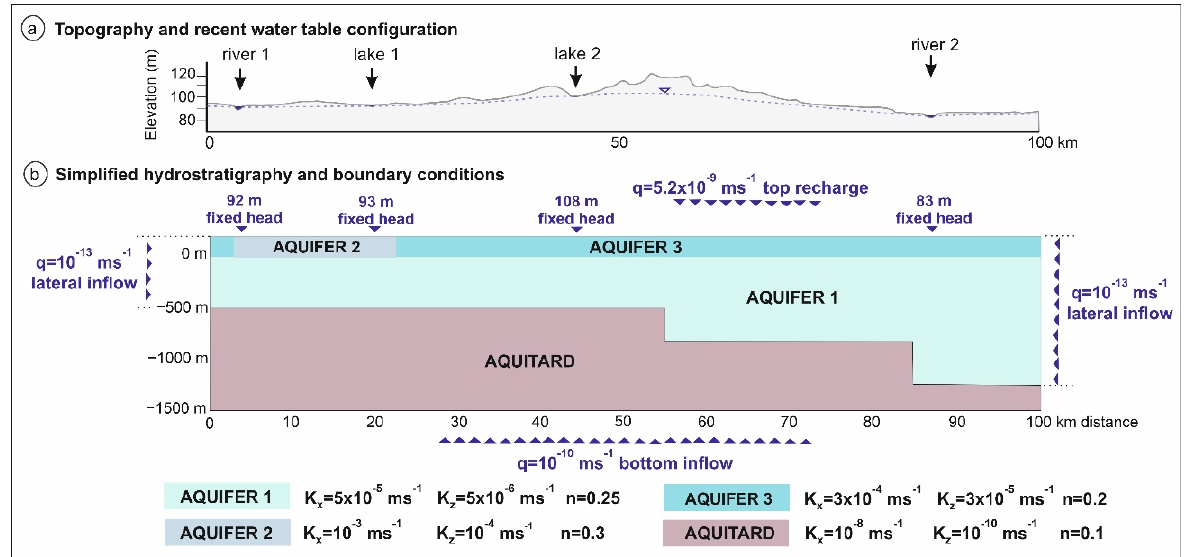
Figure 2. ( a ) Topography and recent water table configuration and ( b ) simplified and generalized hydrostratigraphy applied for the steady-state numerical simulations (based on Figure 1c, K x and K z are horizontal and vertical hydraulic conductivity, n is the porosity of the given unit). Note that in case of the transient simulation, the water table configuration obtained from the steady-state simulation was used as the initial condition; fixed heads were eliminated, and thus, the water table elevation change below the lakes was calculated by the model based on the predicted decrease in recharge across the top boundary over each time step. Darcy flux of the bottom inflow varying in the different tested scenarios: q = 0 ms − 1 was applied for the pure gravity-driven case, q = 5 × 10 − 11 ms − 1 for the lower overpressure case, q = 10 − 10 ms − 1 for the medium overpressure case and q = 5 × 10 − 10 ms − 1 for the higher overpressure case.